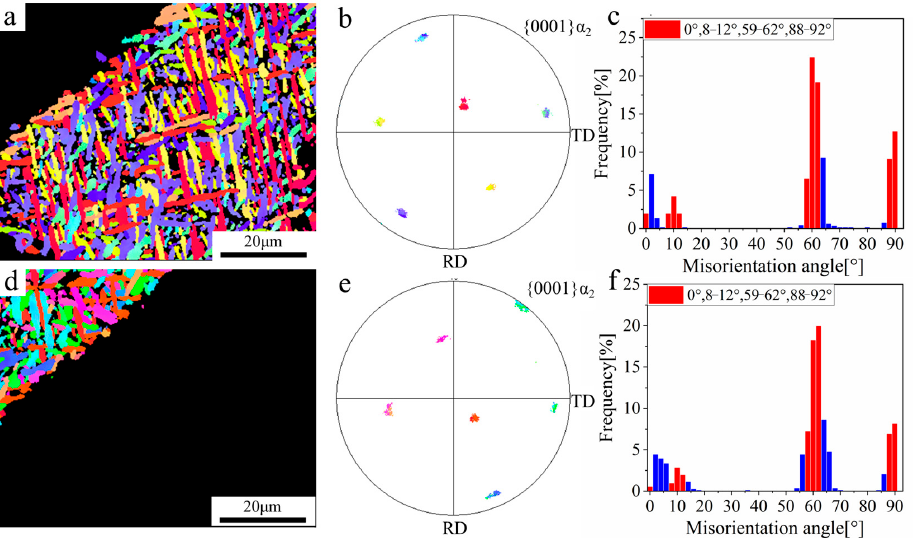
Figure 4. EBSD measurement of α 2 phase in the weld zone of sample 1#. Two groups are divided. ( a , d ) are texture maps of each group; ( b , e ) are pole figures of each group; ( c , f ) are corresponding misorientation angles. Figure 5a is the α 2 phase texture map. All the α 2 grains are orientated in different directions. The dendrites, which are presented in black color, are located in the middle of α 2 grains. In the {0001} α 2 pole figure, basal planes of the α 2 phase are randomly